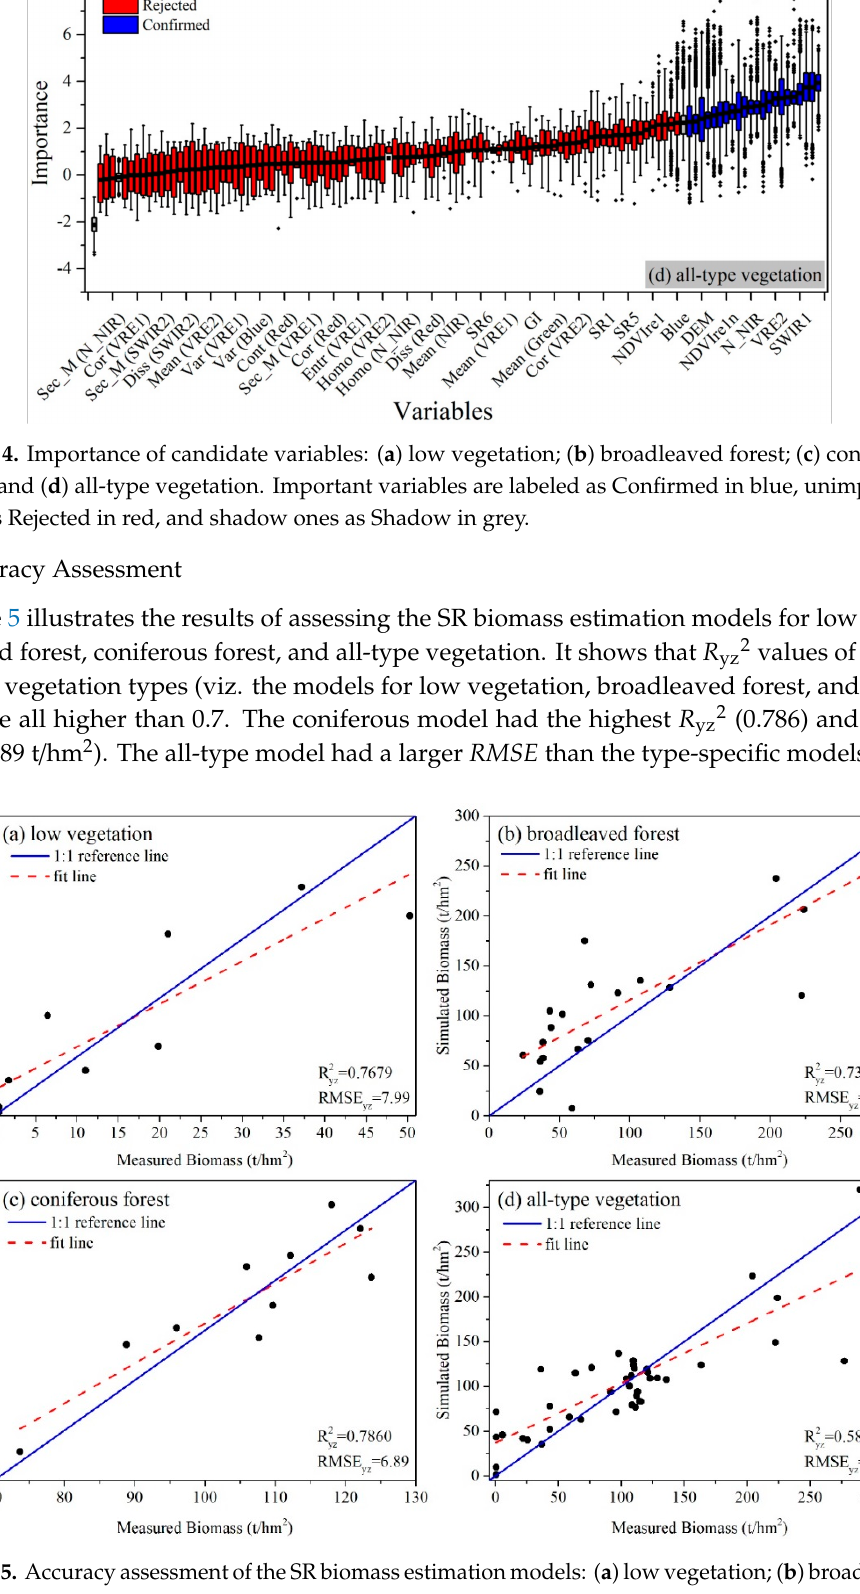
Table 8. Comparing the accuracies of the SR and MLR biomass estimation models (unit for RMSE : t/hm 2 ). Vegetation Type